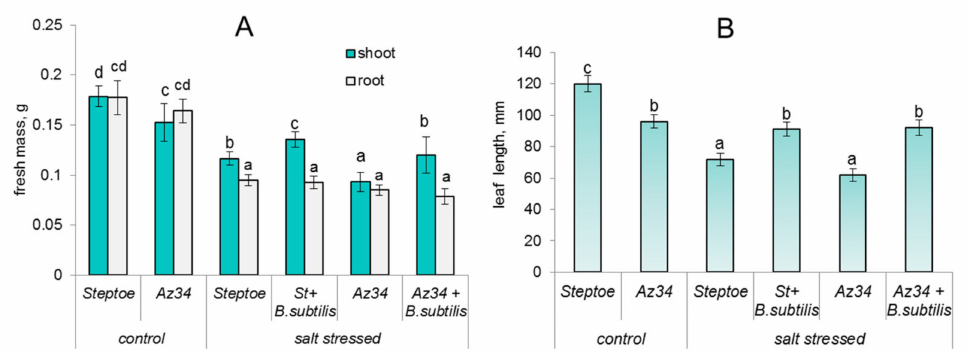
Figure 1. Influence of B. subtilis IB-22 on the fresh weights of shoots and roots ( A ) and leaf length ( B ) of control (unstressed) and salt-stressed (100 mM NaCl) ABA-deficient barley mutant (Az34) and its parental cultivar Steptoe measured on the 8th day after bacterial treatment. Significantly different means for each variable are labeled with different letters at p ≤ 0.05, n =